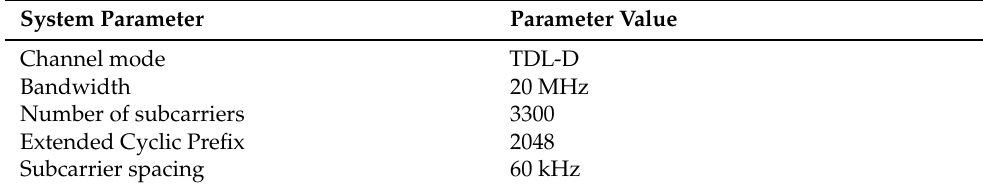
Table1. The 5G NR Rel.15Simulation Parameters.